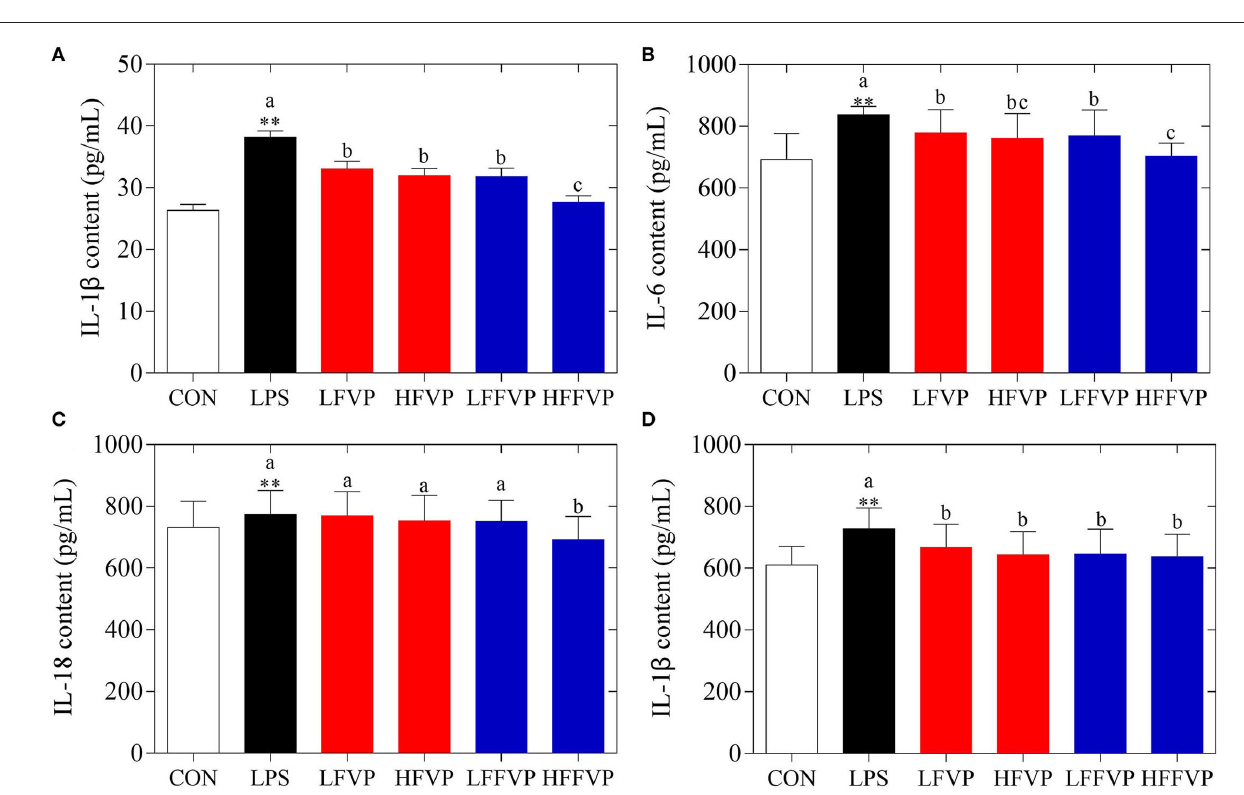
FIGURE 2 | Serum inflammatory factor contents, including IL-1 β (A) , IL-6 (B) , IL-18 (C) , and TNF- α (D) . Mice were stimulated with 3 mg/kg LPS and/or 50 and 100 mg/kg FVP and FFVP. CON group, LPS group (3 mg/kg LPS), FVP and FFVP groups (50/100 mg/kg FVP and FFVP plus 3 mg/kg LPS). FV, Flammulina velutipes ; FVP, Flammulina velutipes polysaccharides; CON, control group; LPS, lipopolysaccharide; LFVP, low dose FVP group; HFVP, high dose FVP group; LFFVP, low dose FFVP group; HFFVP, high dose FFVP group. ** P < 0.01 represents LPS vs. CON group; a, b and c ( P < 0.05) represent FVP and FFVP groups vs. LPS treated